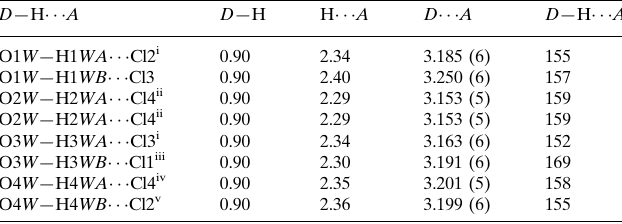
Hydrogen-bond geometry (A˚ , (cid:4)